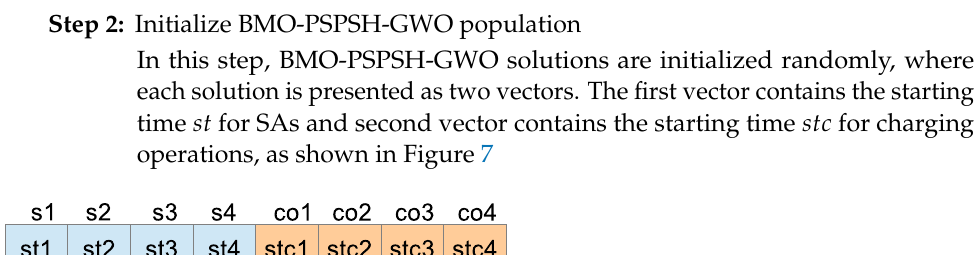
Figure 6. Flowchart of the proposed BMO-PSPSH-GWO method.